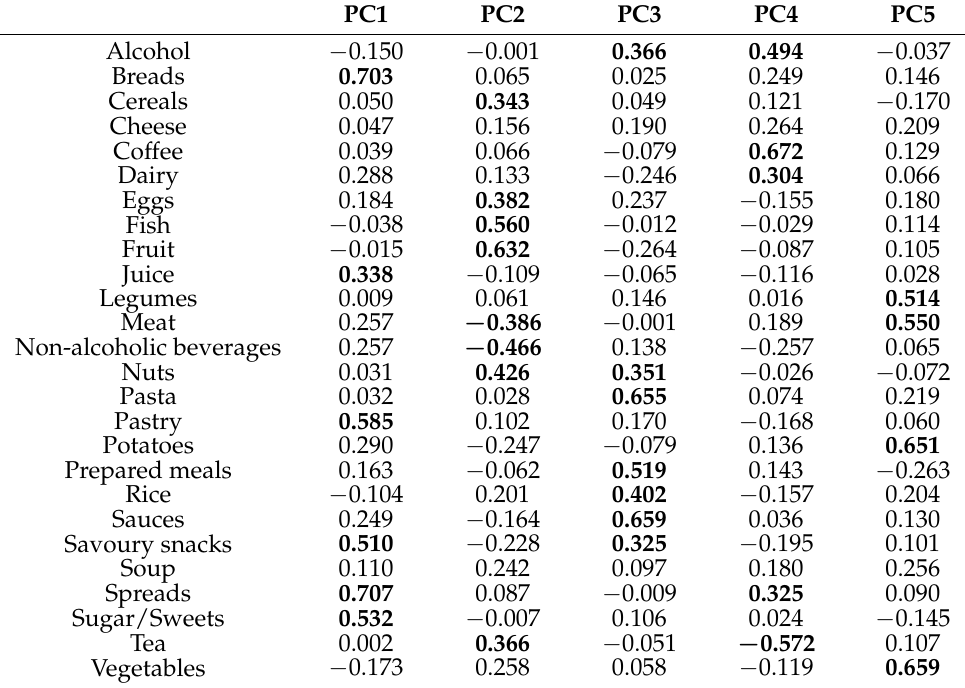
Table 3. Characteristics of dietary patterns derived from PCA with varimax